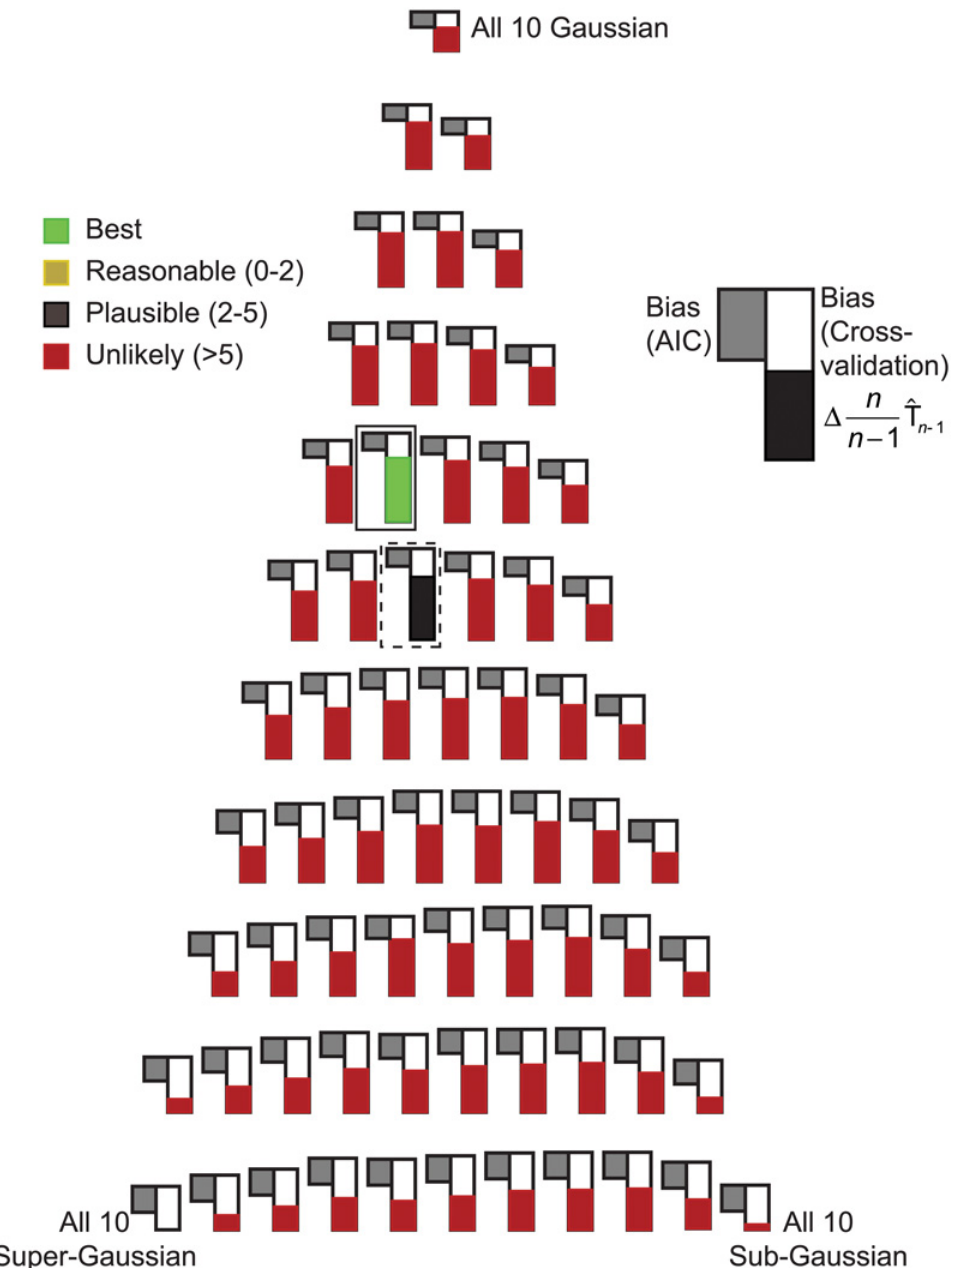
Fig 5. Cross-validation results for the craniometric dataset. For each of the 66 model categories, the best fitting model within the category is shown. The ^ T relative to the poorest fitting category, and the solid white bar above it represents the solid bar in color on the right represents the increase in n n (cid:4) 1 n (cid:4) 1 estimated bias in the optimized log-likelihood of the model as an estimate of T n . The bar on the left shows the AIC bias estimate based on the number of freely adjustable parameters in the model. The best fitting model is enclosed by a solid box. The dashed box encloses the model category that included the second and third best fitting models.